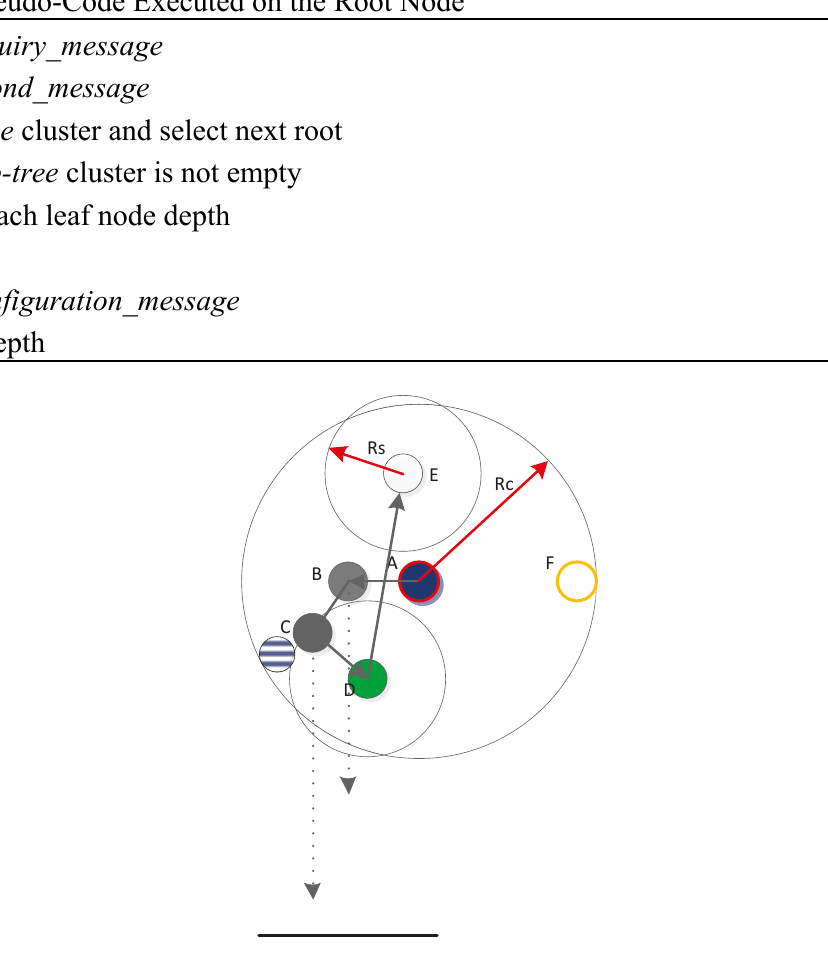
Figure 2. First example of node